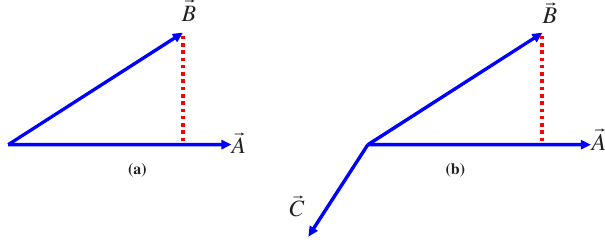
TABLE II. Evaluations of the MIET.